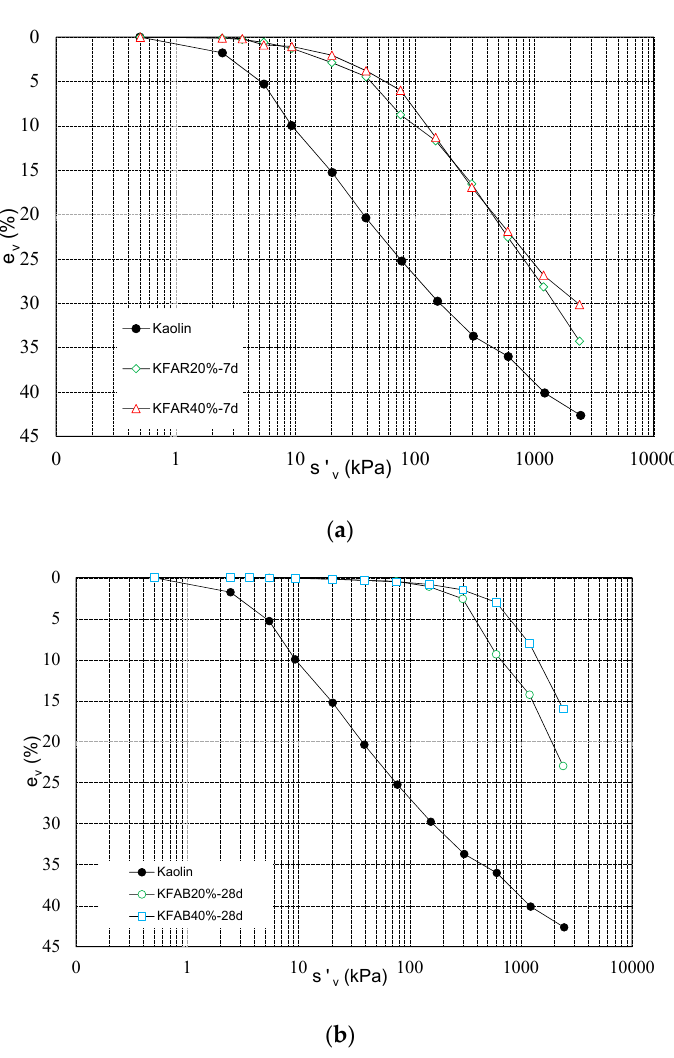
Figure 4. One dimensional compression tests on not treated and treated kaolin as function of binder content: ( a ) KFAR20% vs. KFAR40%—7 days of curing; ( b ) KAFB20% vs. KAFB40%—28 days of curing.